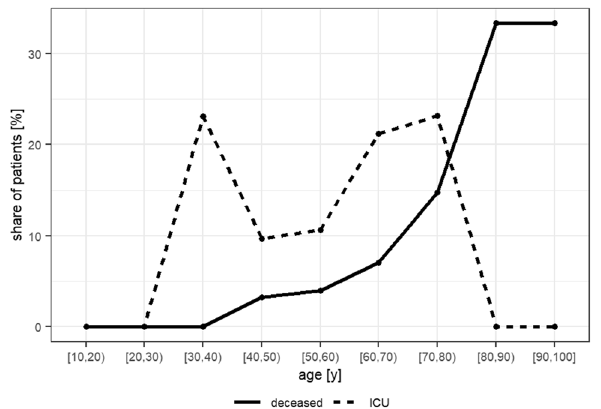
Figure 2. Case fatality rate (line “deceased”) and share of patients treated in the ICU (line “ICU”) visualized for each different life-decade seperately.